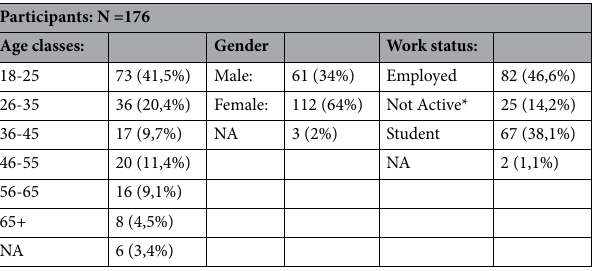
Table 9. Socio-demographic data of the experimental sample. Percentages are out of the total number of participants, N=176. *Not Active refers to: housewives, retired, unemployed and unoccupied